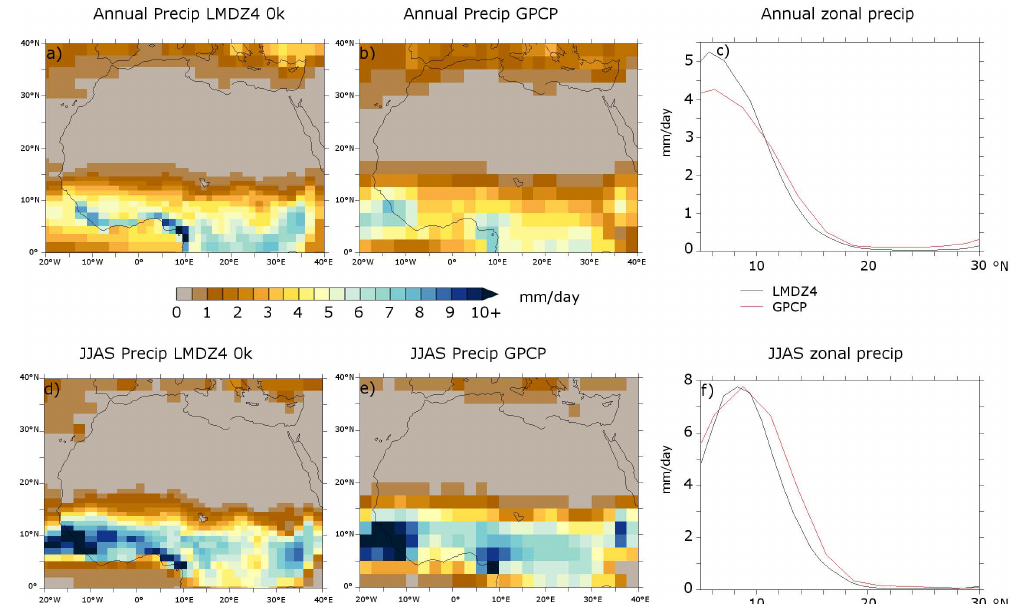
Fig. 3. Top: comparison of annual mean precipitation between the control run (left) and GPCP mean precipitation for years 1979–2010 (centre). Bottom: same for June to September mean